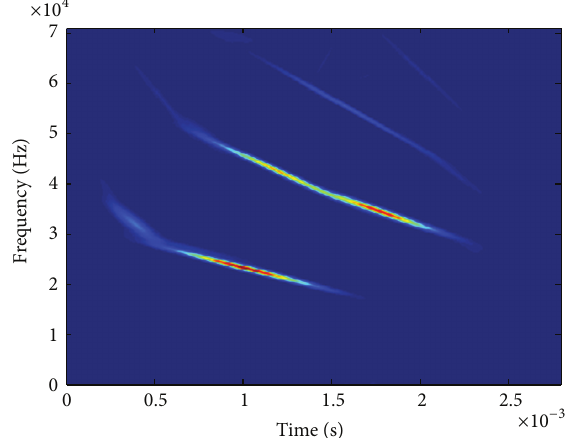
Figure 19: CT spectrogram of Eptesicus fuscus bat echolocation signal.